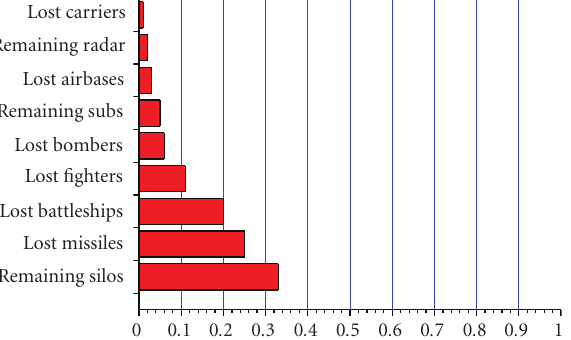
Figure 4: Pearson product-moment correlation coe ffi cient for loss/retention of resources.